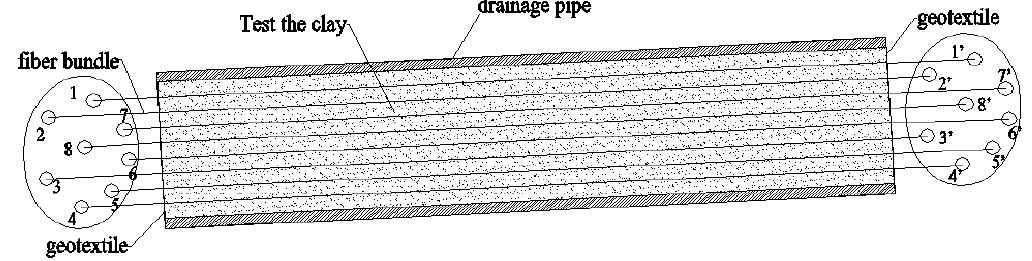
Figure 15. A schematic diagram of the fiber bundle drainage pipe arrangement.